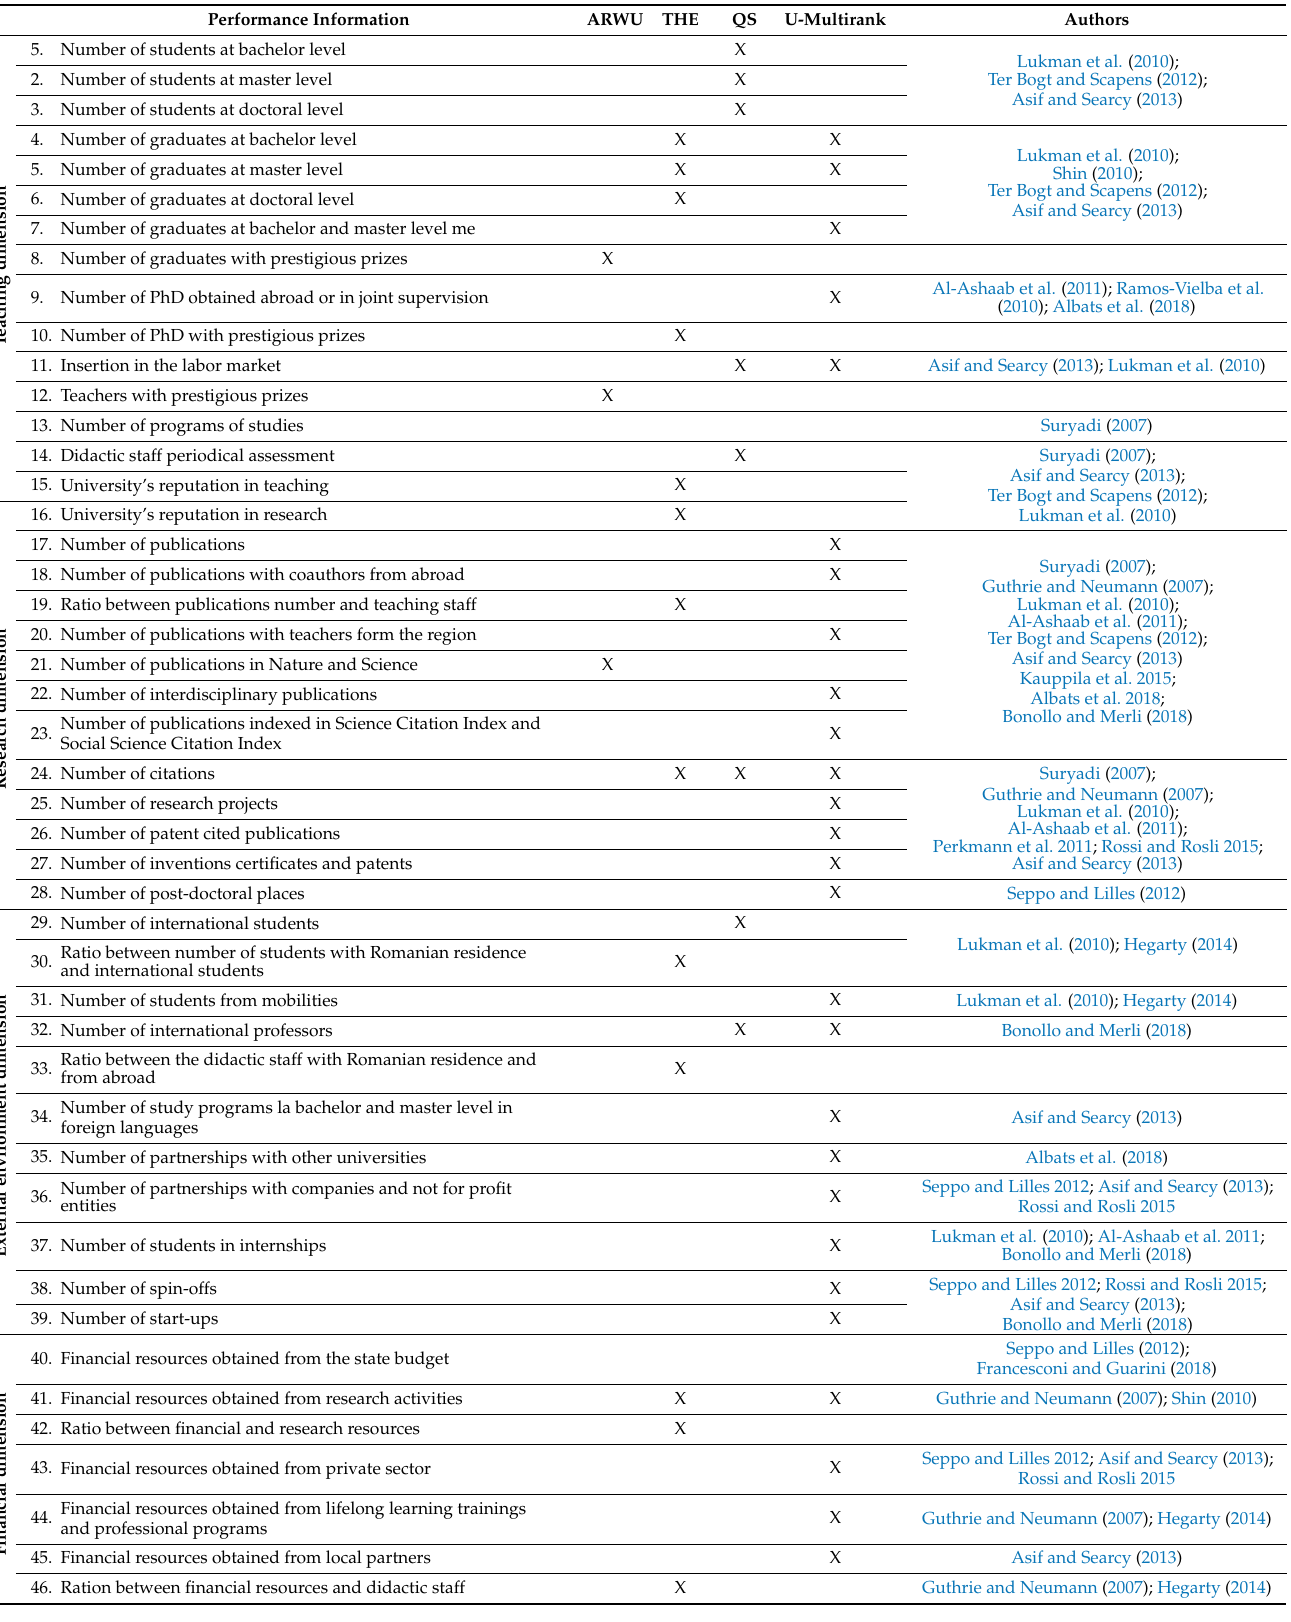
Table A1. Performance-reporting disclosure